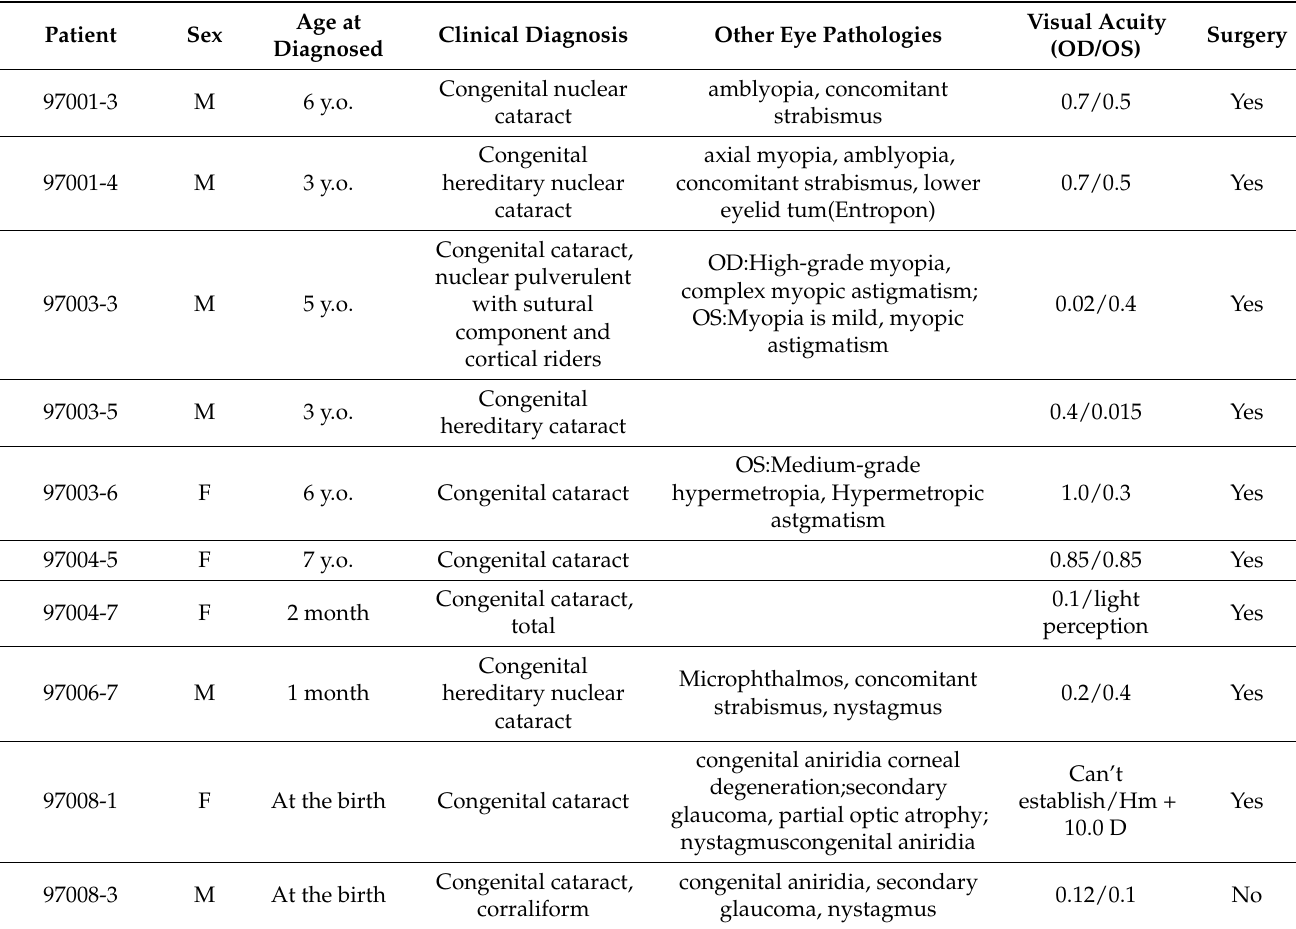
Table 1. Clinical data for the Congenital Cataract patients.